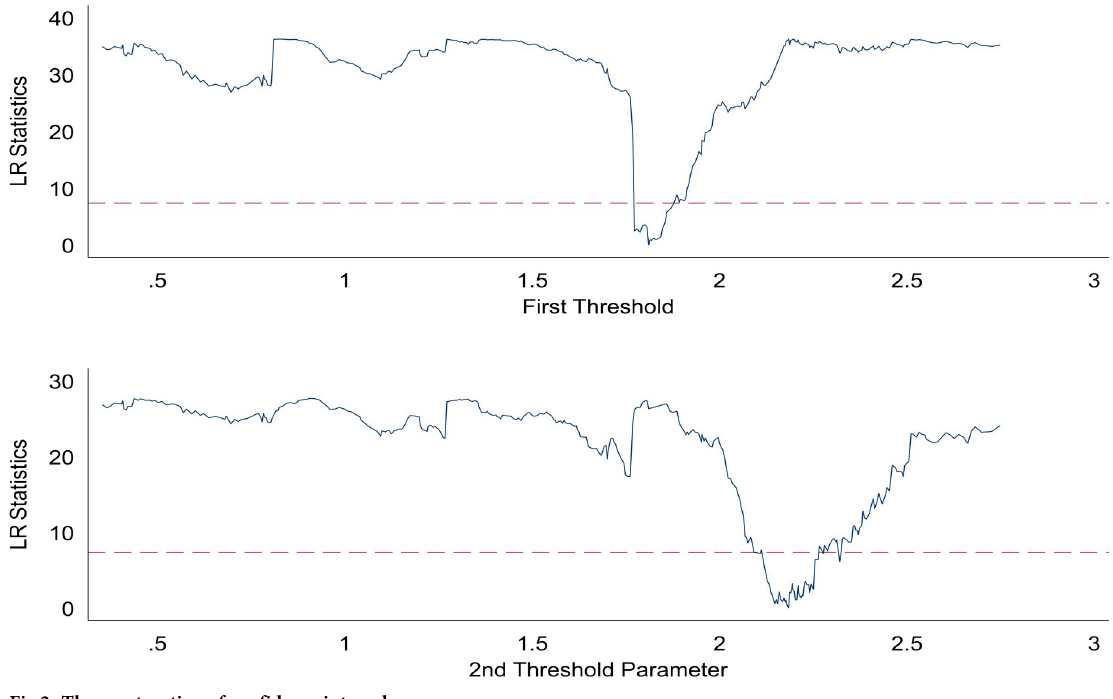
Fig 2. The construction of confidence